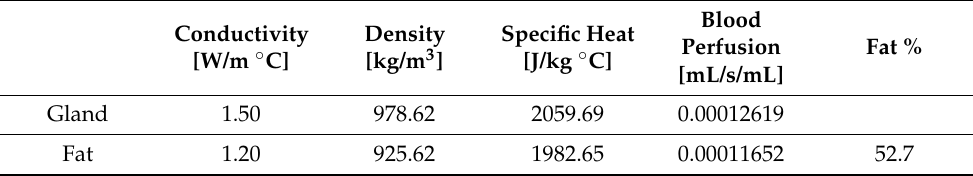
Table 8. Estimated specific breast parameters (patient